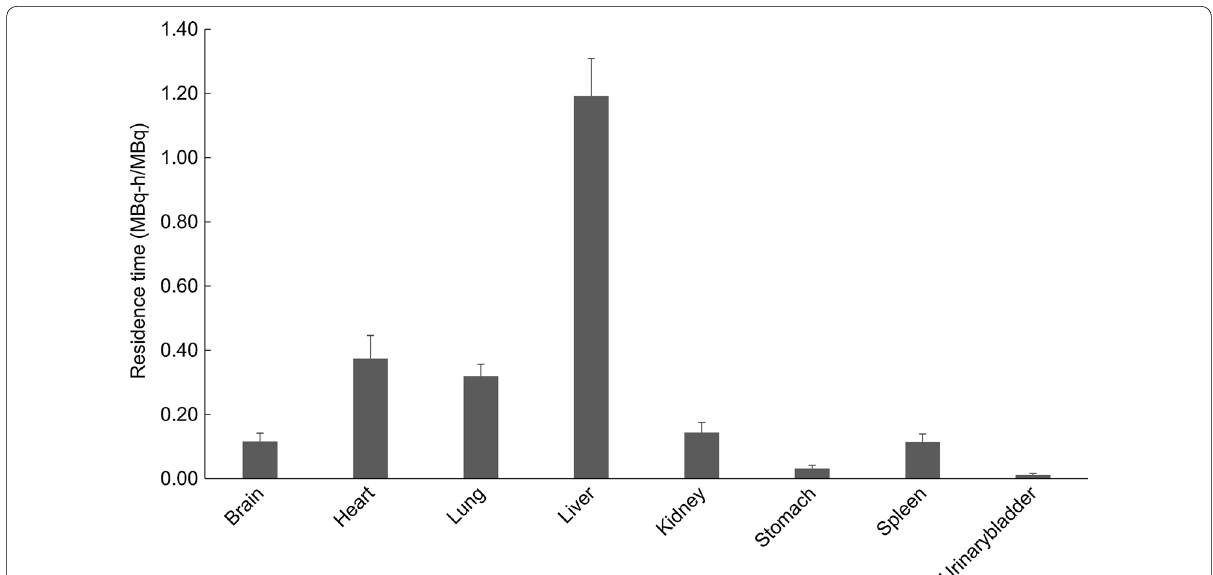
standard deviation) for ±